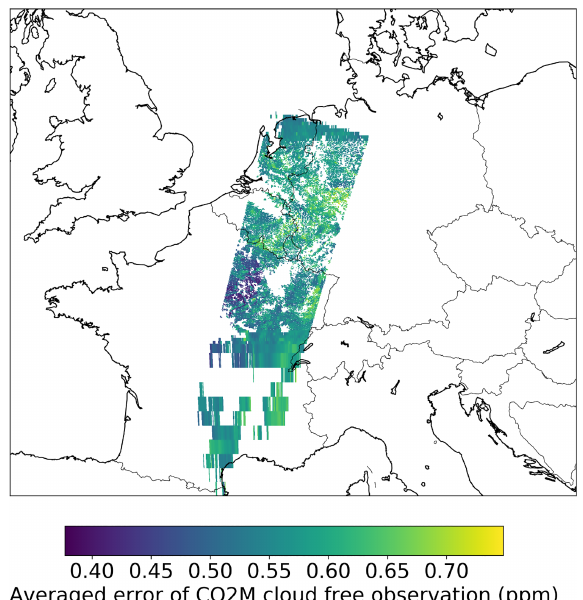
Figure 6. Simulation of the XCO 2 sampling and observation er- ror standard deviation (by IUPB in the ESA-PMIF project) for a selected orbit of the spectral imaging satellite, in parts per million